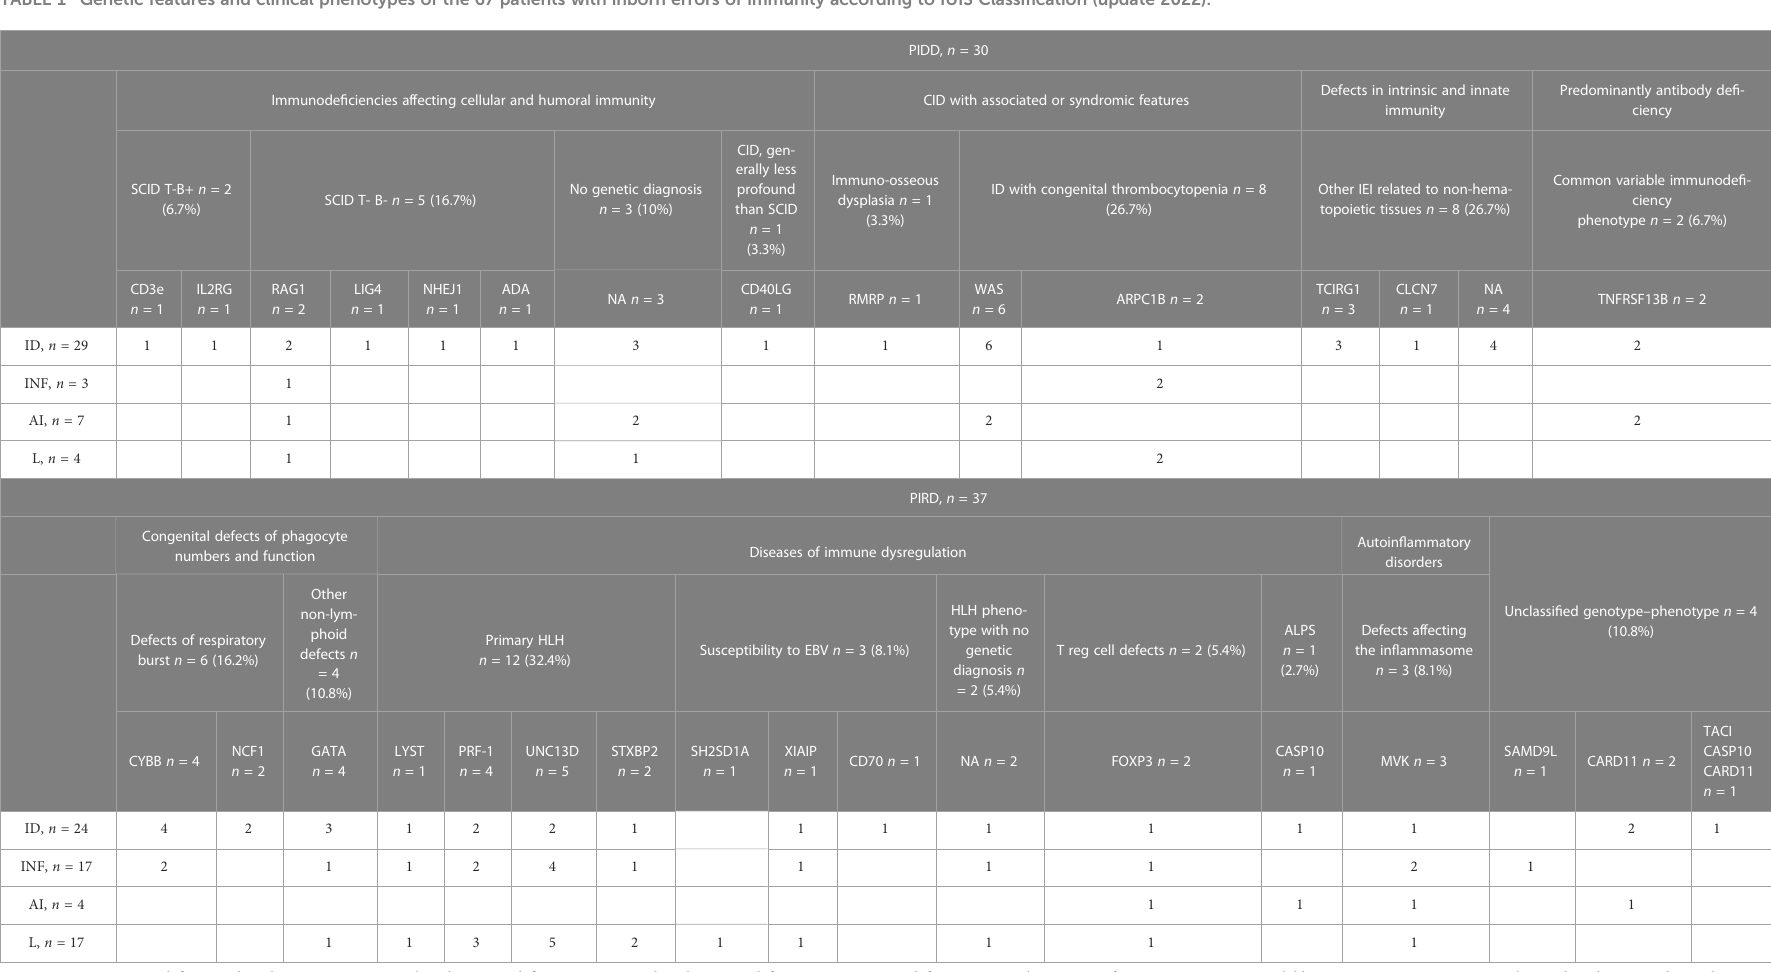
TABLE 1 Genetic features and clinical phenotypes of the 67 patients with inborn errors of immunity according to IUIS Classi fi cation (update